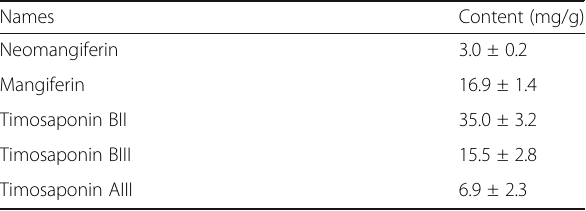
Table 4 The content of the main compounds content in A. asphodeloides as measured by HPLC